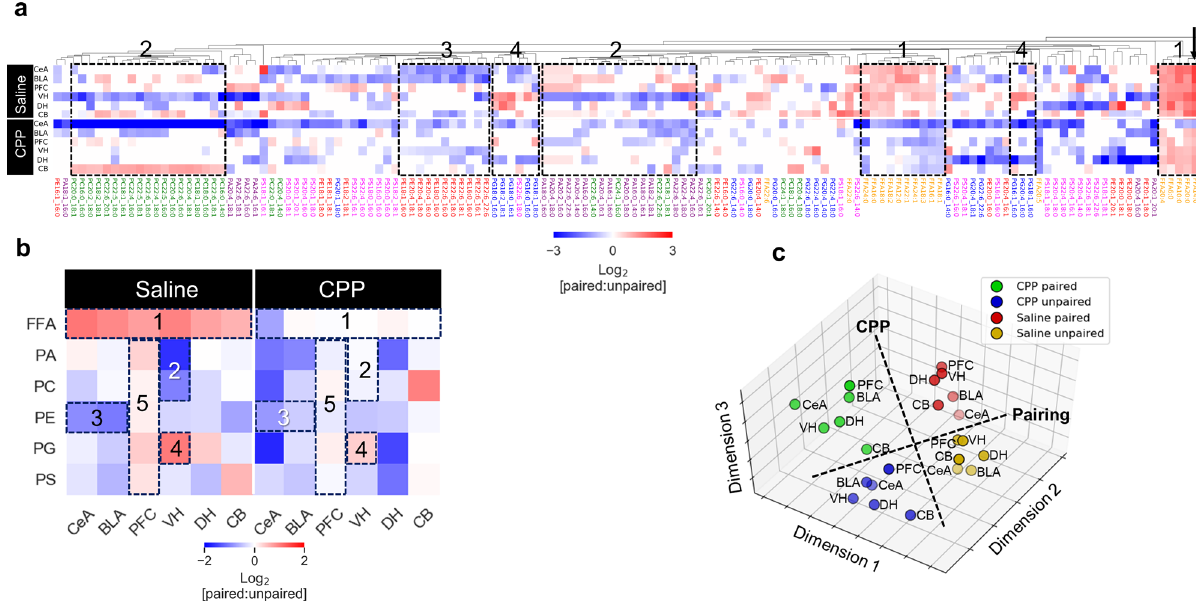
Fig. 3 FFA and phospholipid responses to AFC. a Hierarchical clustering heatmap, where each pixel represents the mean fold-change response (paired versus unpaired AFC) of the indicated analyte from 8 animals, in a given brain region. White pixels represent analytes whose change in abundance was not signi fi cant (two-tailed t -test p > 0.05). Dotted boxes highlight regions of the heatmap demonstrating strong activity-dependent change of a particular lipid class as described in the main text. The arrow shows the particularly strong response of myristic acid (C14:0). b Simpli fi ed heatmap indicating total response (paired versus unpaired AFC) of all lipids of a given class in each brain region. Dotted boxes correspond to those in a . c Multivariate analysis of the 24 FFA pro fi les representing 6 brain regions and 4 AFC conditions (Supplementary Fig. 4), where each dot represents 18 normalized mean FFA concentrations observed across 8 animals. The isomap algorithm was used for non-linear dimensionality reduction from 18 to 3 dimensions. The 3D projection has been manually rotated to highlight the differences between the pro fi les obtained for each AFC experimental condition. Dashed lines represent a manual assignment of the axes around which the pro fi le datapoints were resolved, according to CPP treatment and AFC pairing. CeA — central amygdala, BLA — basolateral amygdala, PFC — prefrontal cortex, VH — ventral hippocampus, DH — dorsal hippocampus, CB — cerebellum, PA — phosphatidic acid, PC — phosphatidylcholine, PE — phosphatidylethanolamine, PG — phosphatidylglycerol, PS — phosphatidylserine. Source data are provided as a Source Data fi